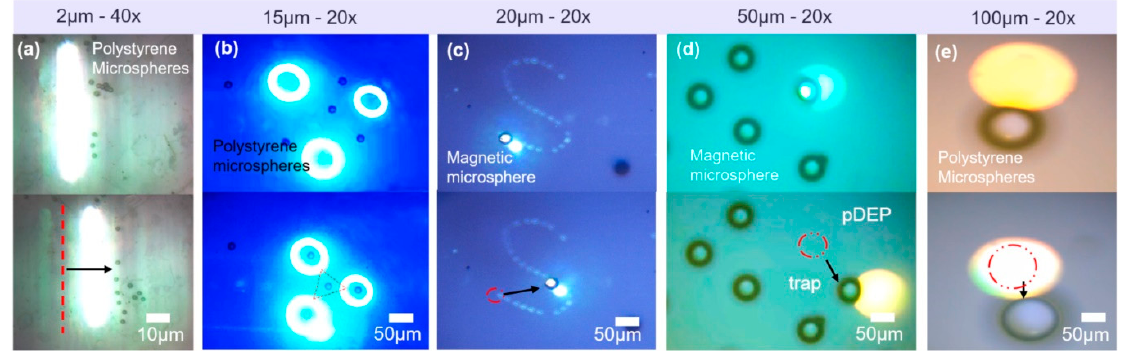
Figure 5. OET systems manipulate particles with different sizes. ( a ) 2 µ m polystyrene microspheres; ( b ) 15 µ m polystyrene microspheres; ( c ) 20 µ m magnetic microspheres; ( d ) 50 µ m magnetic microspheres; ( e ) 100 µ m polystyrene microspheres.